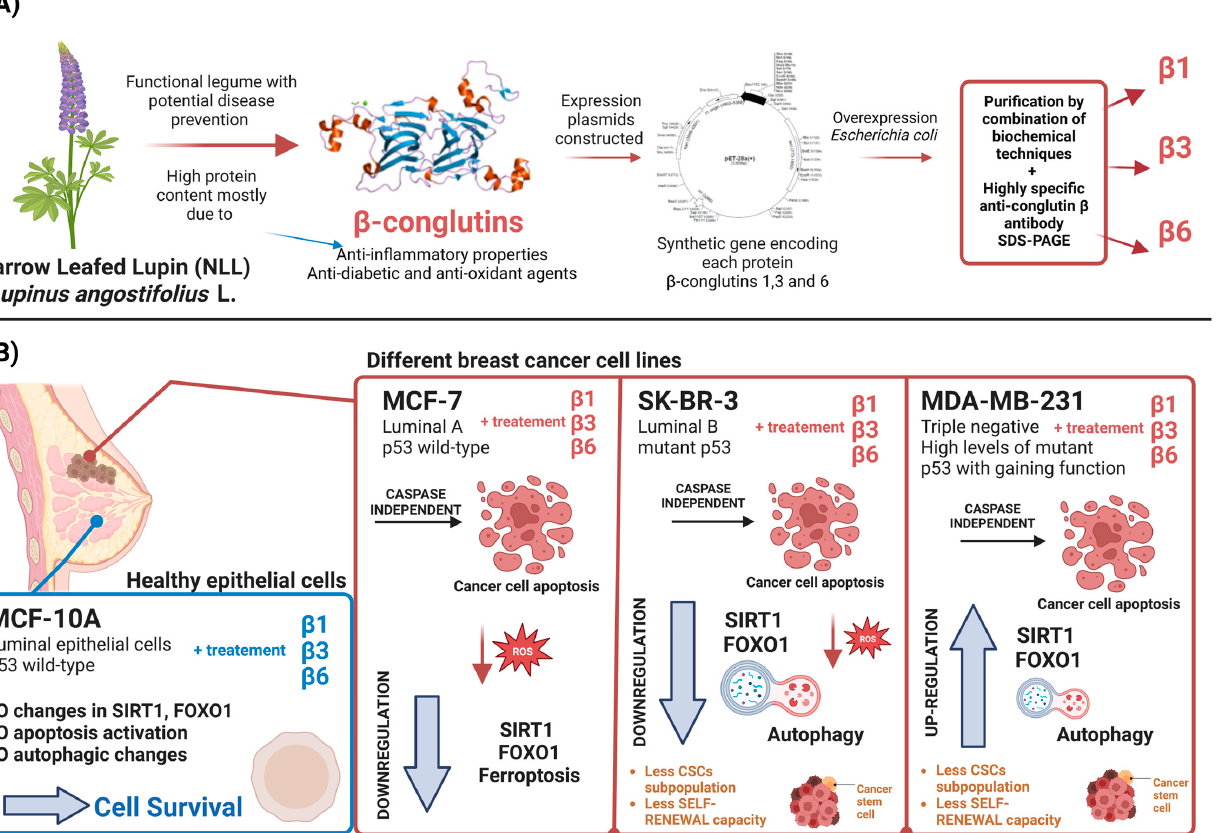
Figure 9. ( a ) Obtention, puri fi cation, and application of β -conglutin treatment in BC cell lines as a cytotoxic and anti-stemness agent against BC cell lines, preserving healthy epithelial cells. ( b ) Regulation of SIRT1/FoxO1 pathway and autophagy in a p53-dependent manner. Created with BioRender.com.